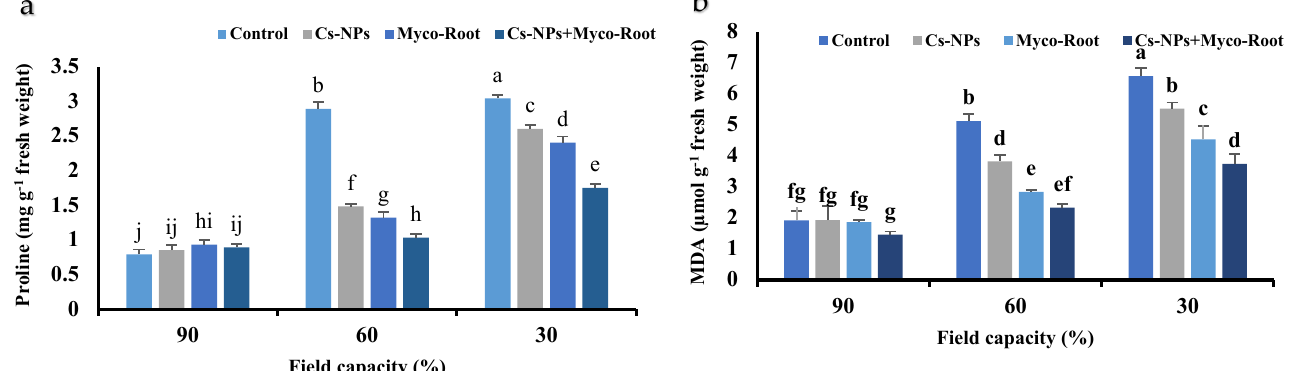
Figure 3. The proline ( a ) and malondialdehyde (MDA) ( b ) content of L. iberica with different fertilizer sources and irrigation levels. Different letters indicate significant differences at the 5% level according to LSD test.